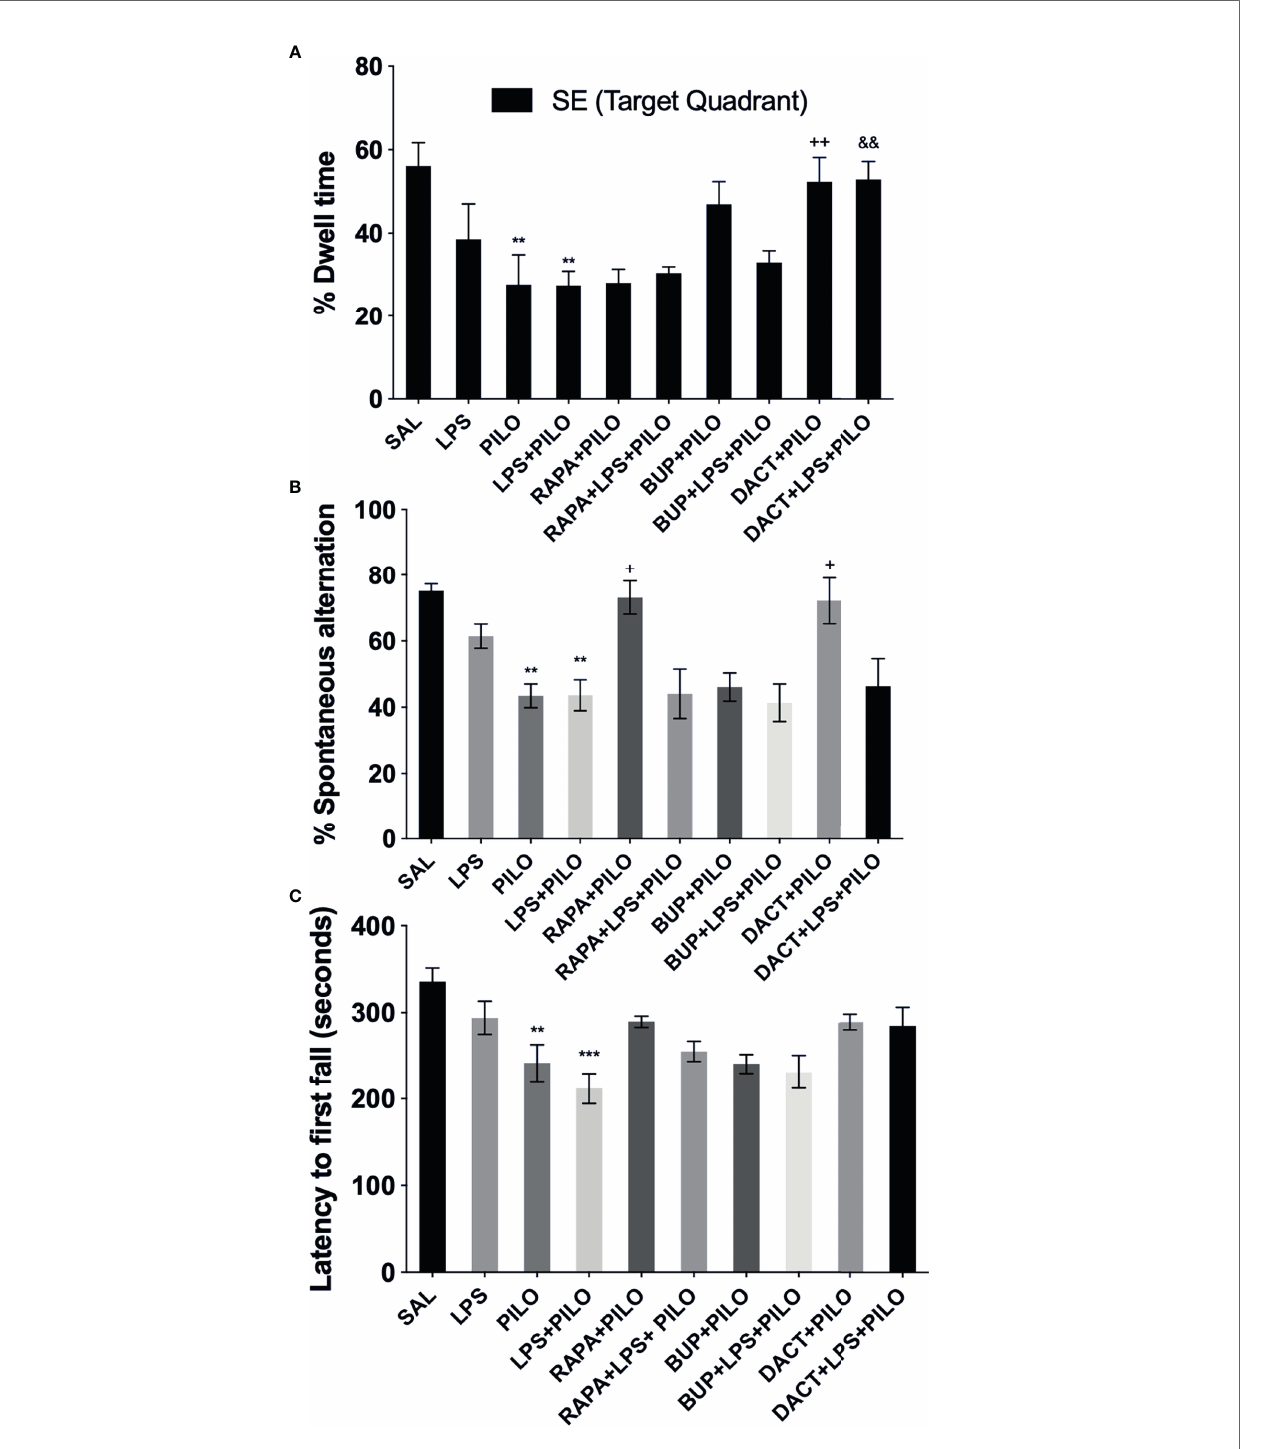
FIGURE 12 | Effects of RAPA, BUP, and DACT on cognitive and motor functions in LPS/PILO-treated C57BL/6 mice. (A) % dwell time in the reference memory test, (B) motor coordination, and (C) % spontaneous alternation. The data are represented as mean ± SEM (n = 5) and analyzed by one-way ANOVA followed by Tukey Kramer multiple comparison tests. ***p<0.001 versus SAL, **p < 0.01 versus SAL, && p < 0.001 versus LPS+PILO, ++ p < 0.01 versus PILO, + p < 0.05 versus